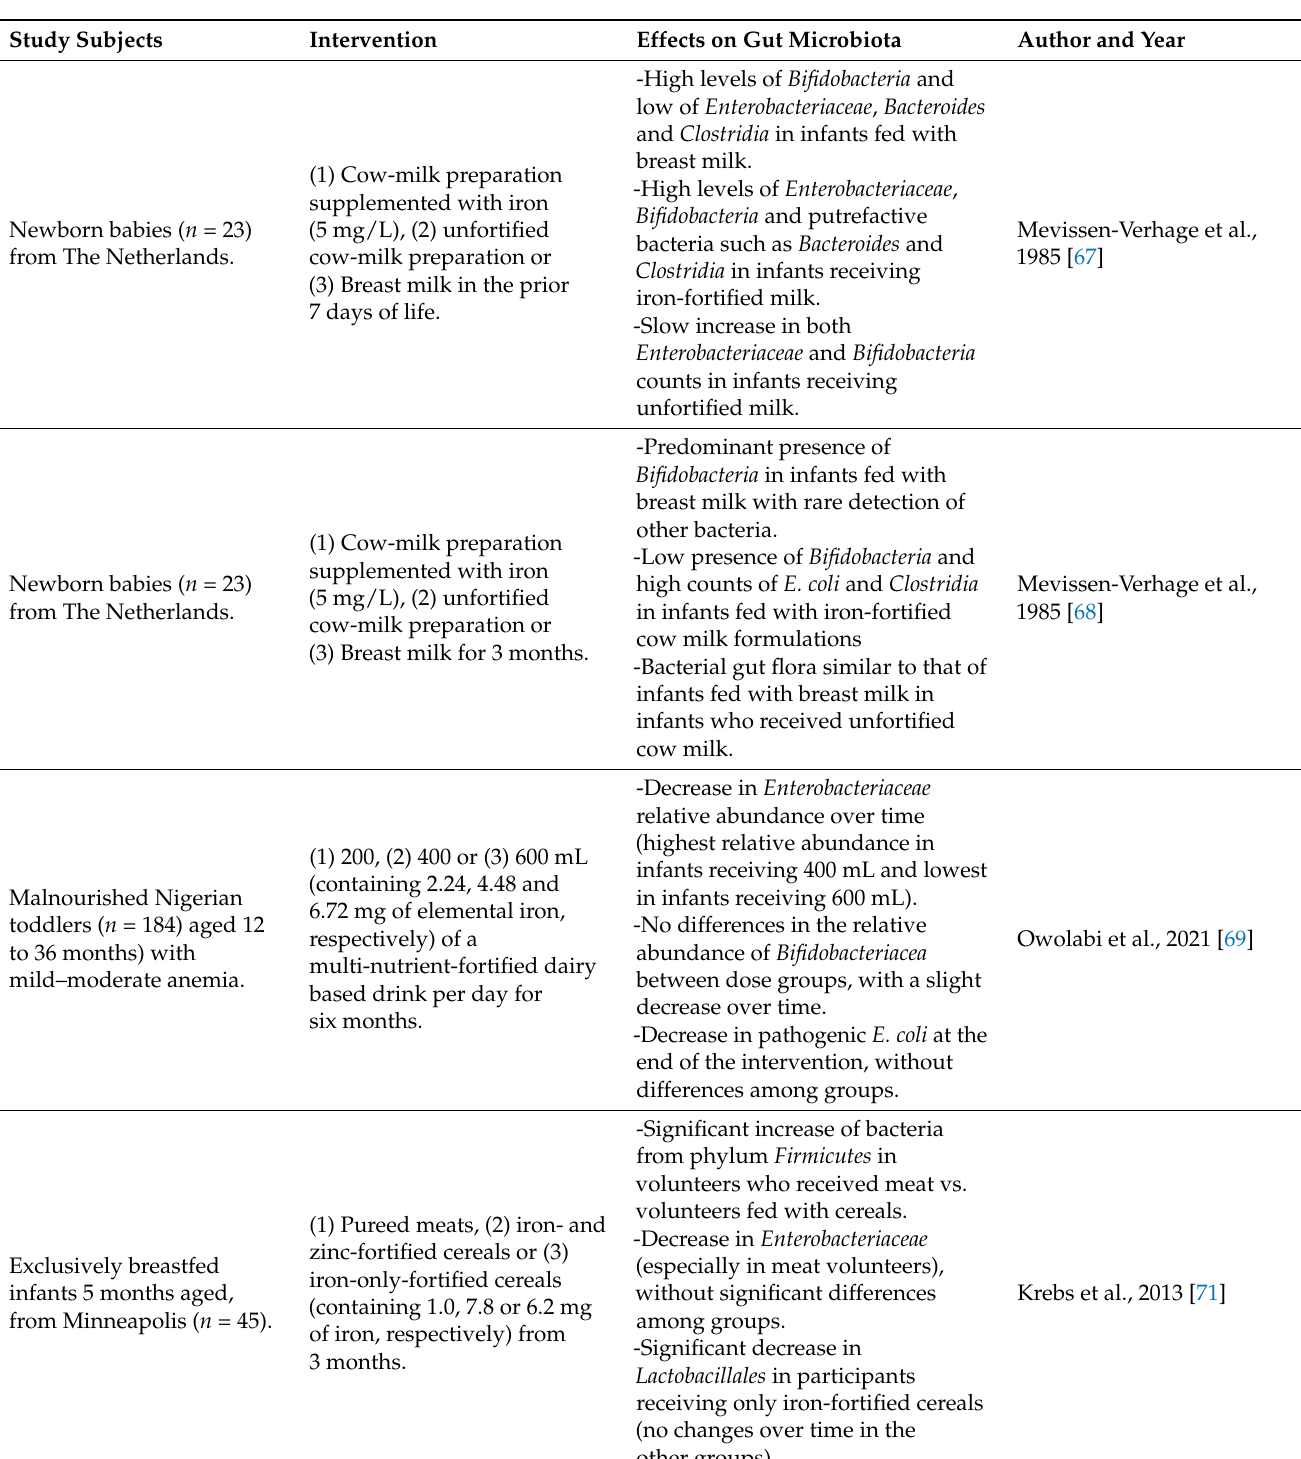
Table 1. Summary of the effects of the intervention studies performed in infants and toddlers on gut